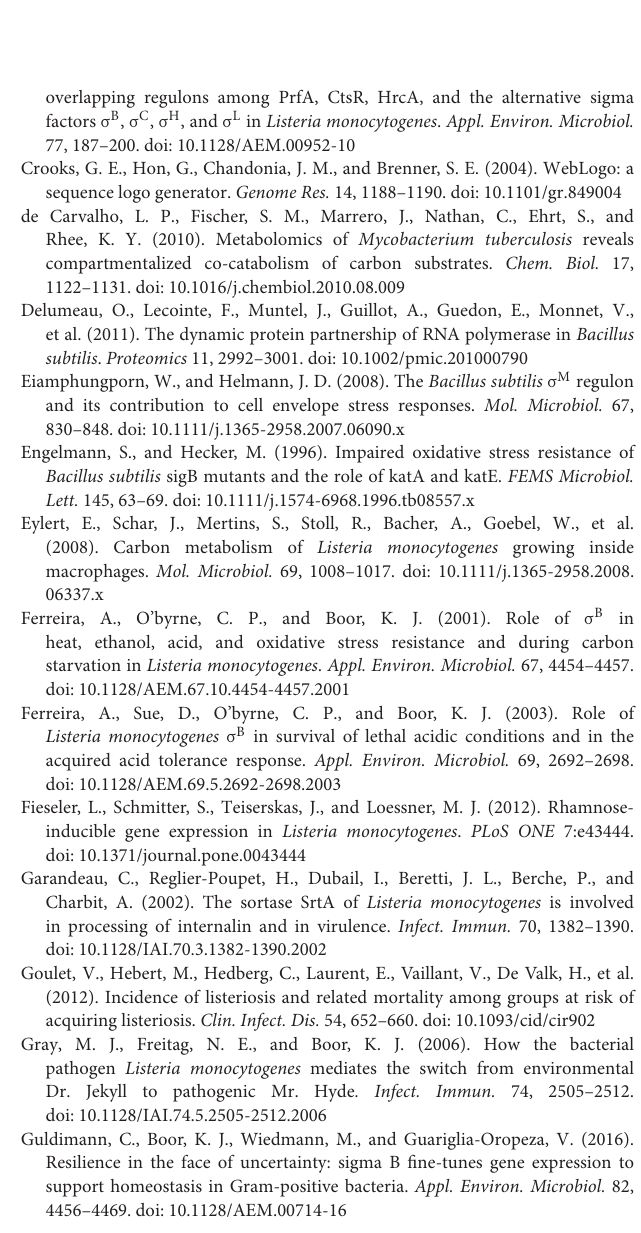
Supplementary Table 3 | Genes downregulated by σ B identified by traditional BaySeq.